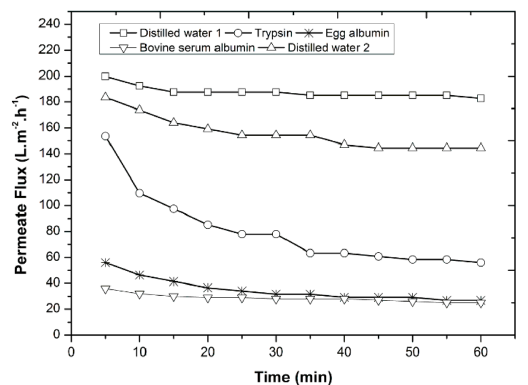
Figure 5. Permeate flux to distilled water and different proteins.